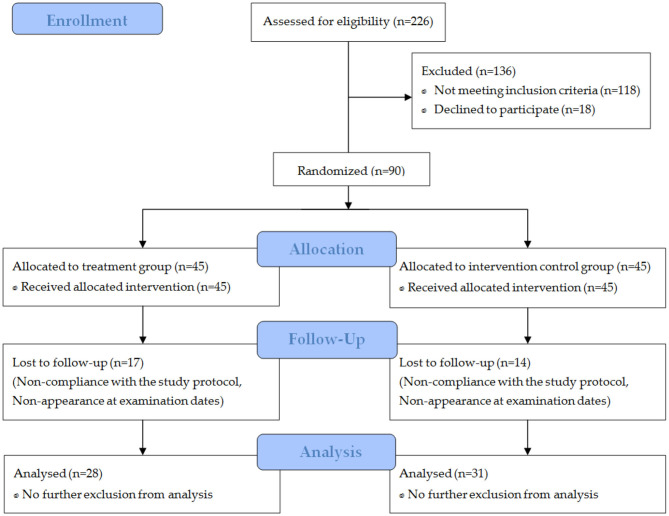
Flow chart of subject recruitment, randomization, and follow-up.